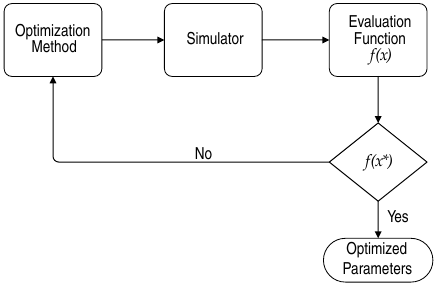
Figure 1. Synthetic flowchart of the optimization